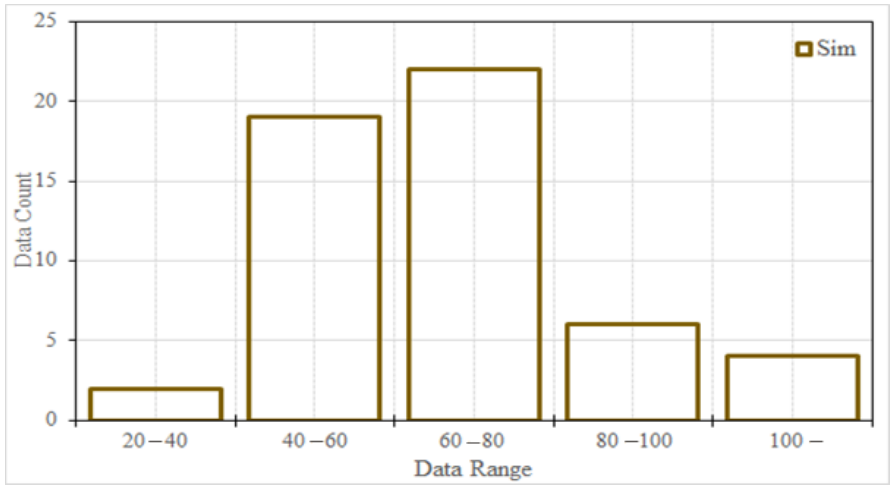
Figure 12. Ungauged watershed threshold rainfall